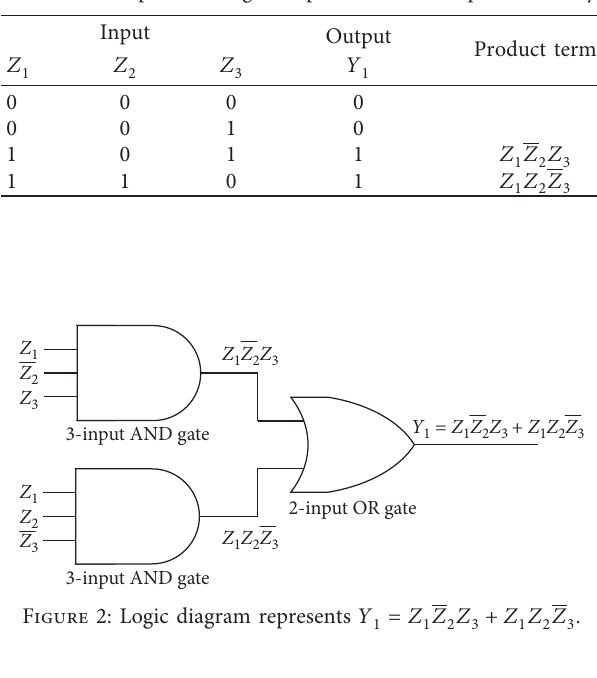
Figure 2: Logic diagram represents Y